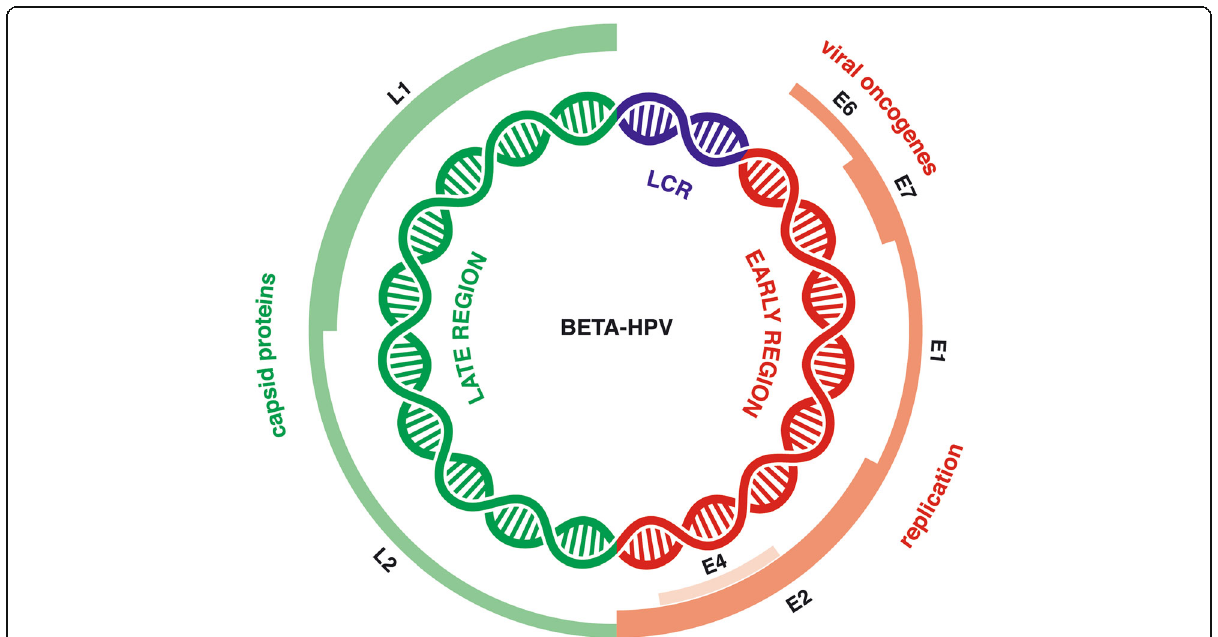
Fig. 5 Schematic representation of beta-HPV genome, showing its three regions: early ( “ E ” ) and late ( “ L ” ) regions, and a non-coding region “ LCR ” ( “ long control region ”